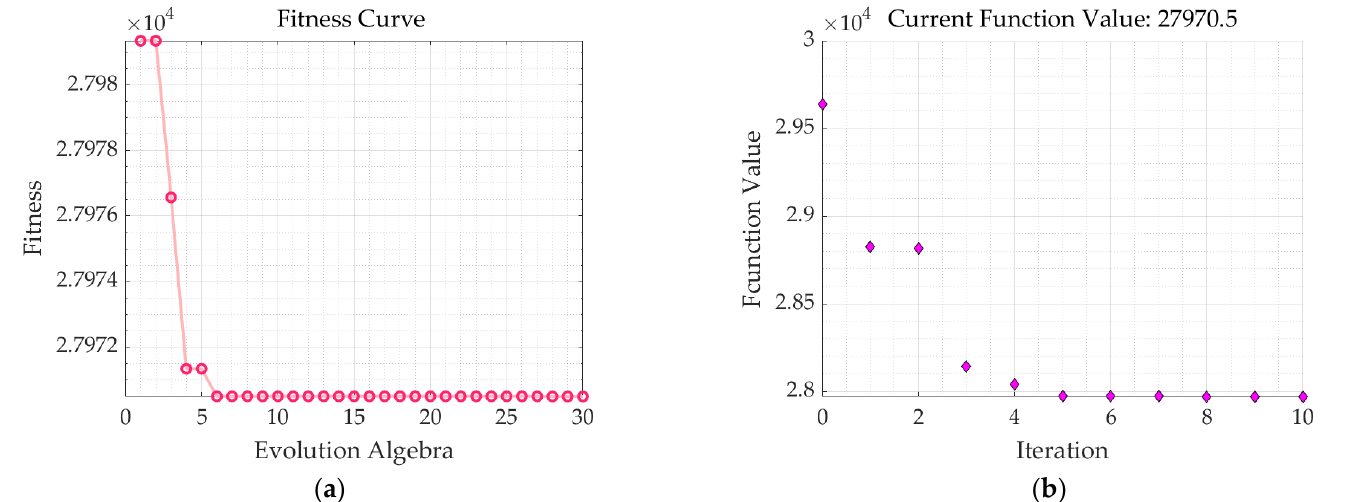
Figure 9. Iterative process of the MSSBN-3 experiment. ( a ) PSO. ( b ) OQNLP. Monte Carlo experiments test the robustness of the algorithm proposed in this paper.